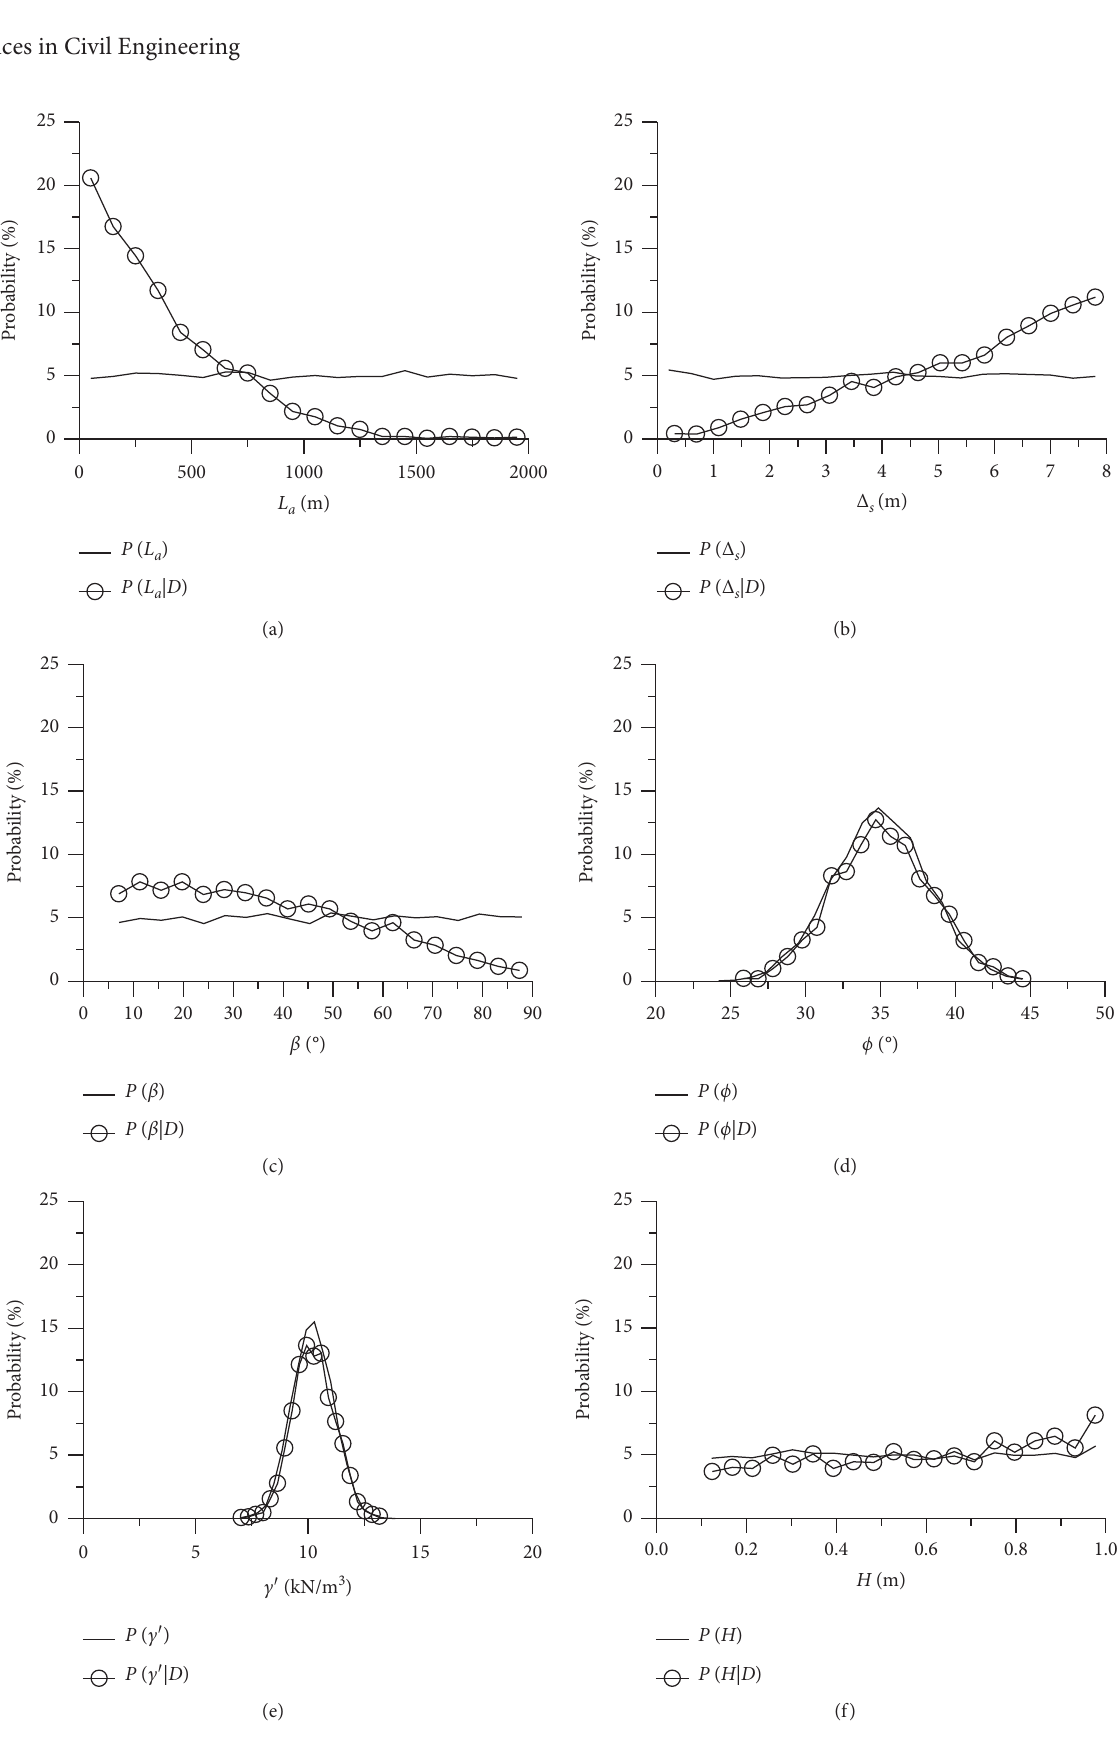
Figure 10: Conditional probability P ( θ | D ) for different θ : (a) θ � anchored cable length, L angle, β ; (d) θ � soil friction angle, ϕ ; (e) θ � effective soil unit weight, c ’; (f) θ � cable burial depth, H